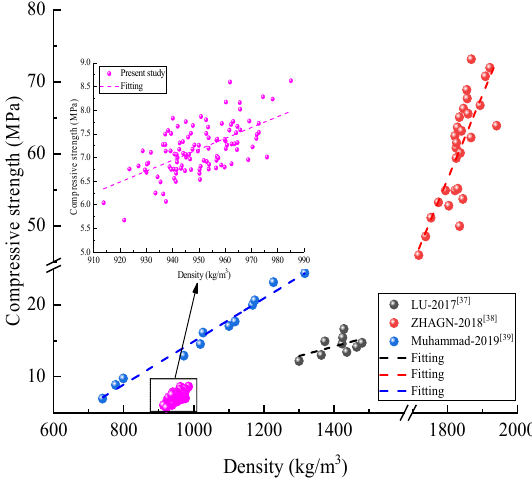
Figure 11. Comparison with previous studies [37–39].